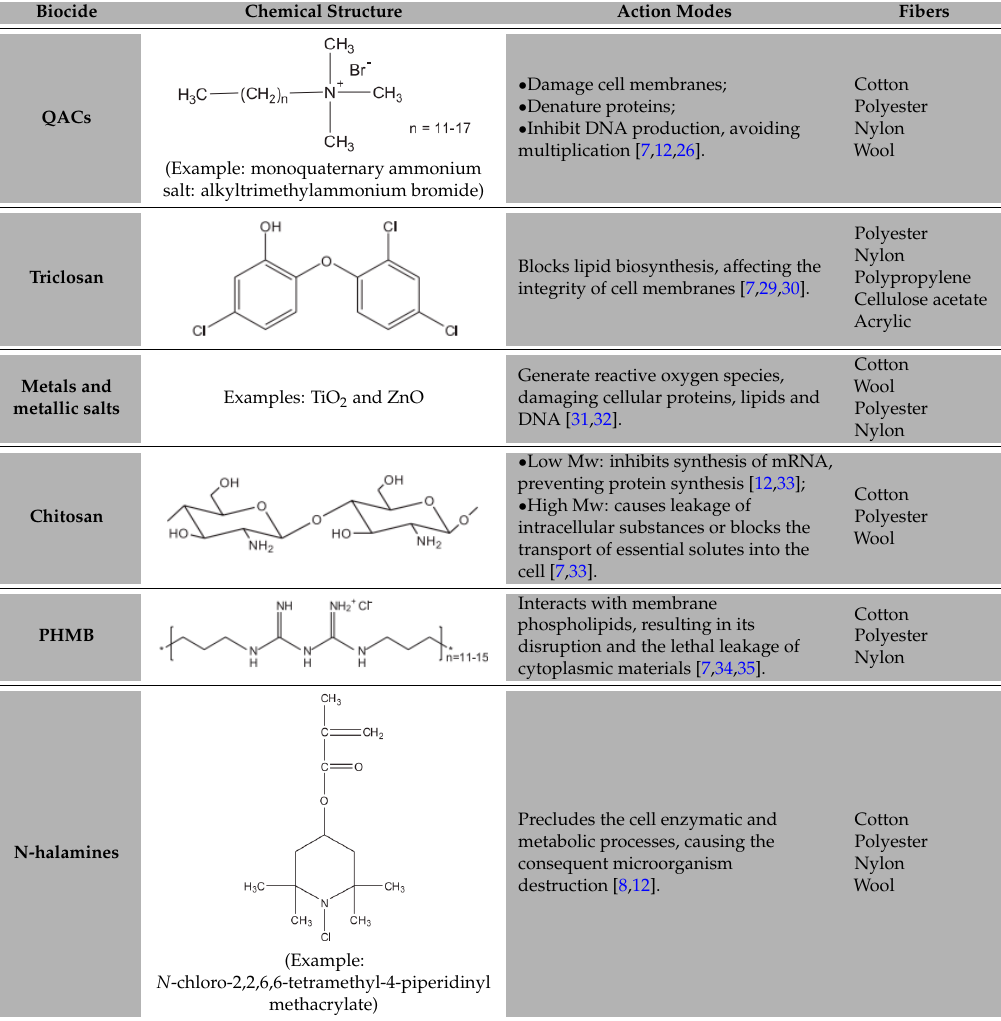
Table 1. Chemical structure and action modes of the main antimicrobial agents, as well as the main fibers in which they are used. QAC, quaternary ammonium compound; PHMB, poly(hexamethylene biguanide).